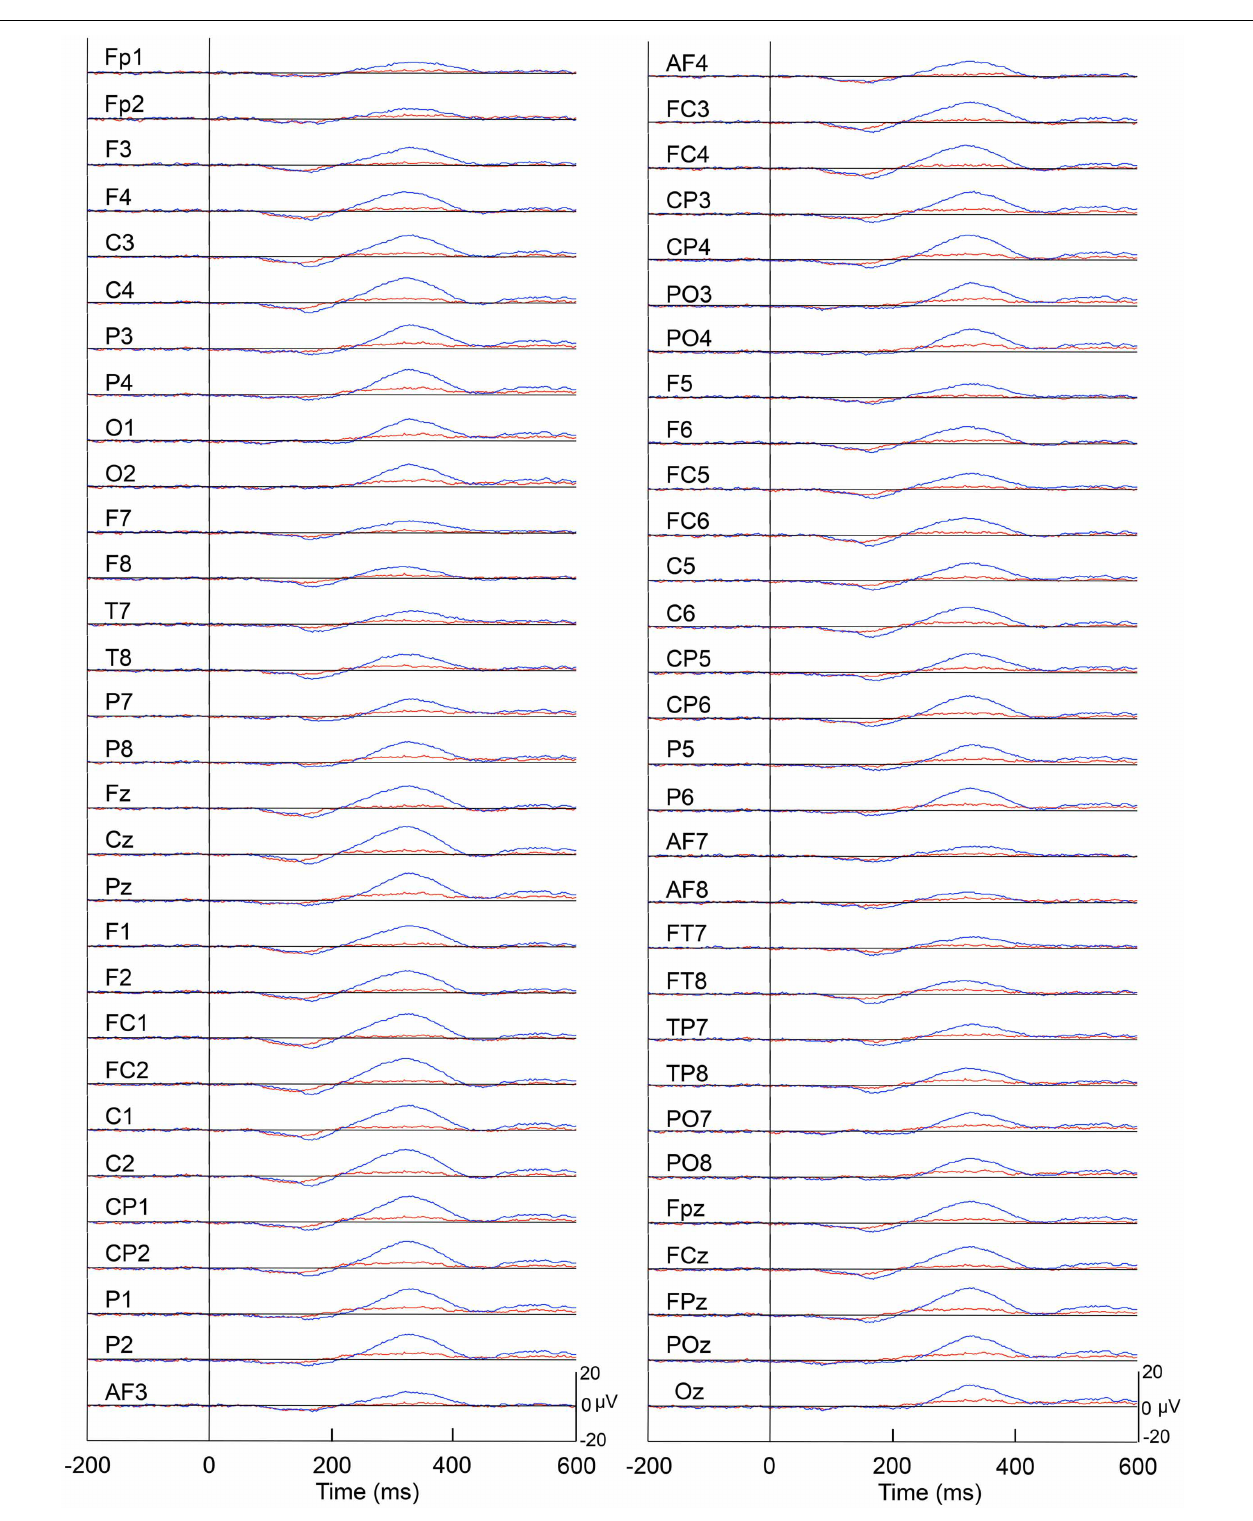
FIGURE 4 | Averaged ERPs with vertex-positivity in the control and test phases. Blue and red recordings indicate averaged ERPs in the test and control phases, respectively. Zero in the time scale indicates arrival at the spatial reference point.